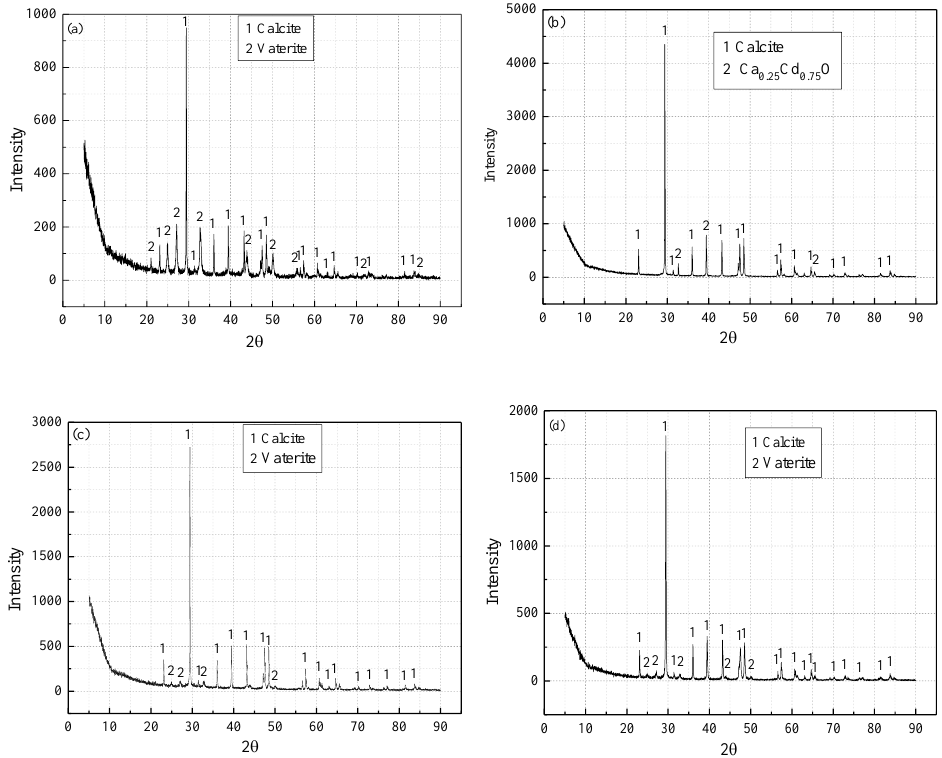
Figure 11. XRD spectra of precipitates (( a ) Ca 2+ precipitate; ( b ) Cd 2+ -Ca 2+ coprecipitate; ( c ) Cu 2+ -Ca 2+ coprecipitate; ( d ) Pb 2+ -Ca 2+ coprecipitate).